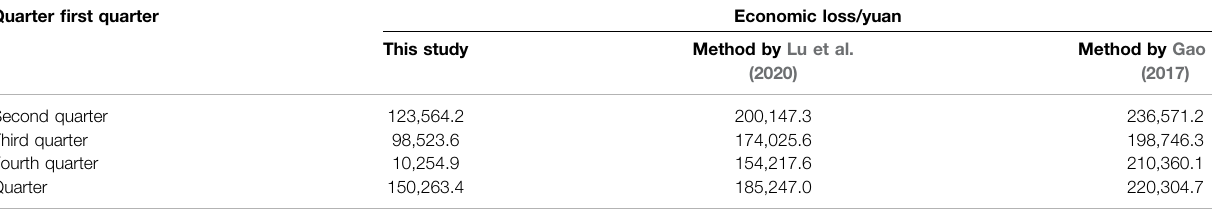
TABLE 4 | Comparison of economic losses in safety risk